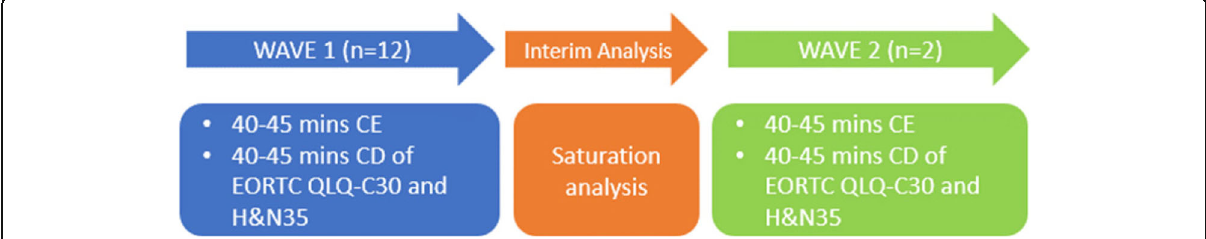
Fig. 2 Wave structure of patient interviews. Abbreviations: CD cognitive debrief, CE concept elicitation; mins, minutes, EORTC QLQ-C30 European Organisation for Research and Treatment of Cancer, Quality of Life Questionnaire, EORTC H&N35 European Organisation for Research and Treatment of Cancer, Quality of Life Questionnaire Head and Neck Module. Note: Wave 2 consisted of a smaller number of participants due to conceptual saturation being